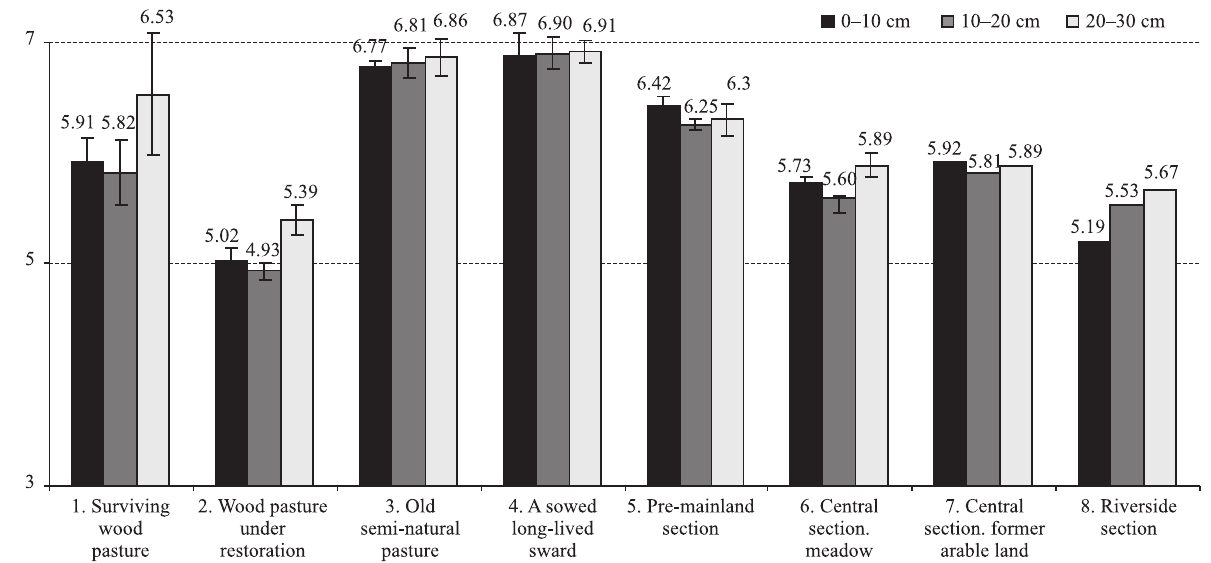
Fig. 1. The pH values in different layers of soil (0–10, 10–20 and 20–30 cm), 2012 Note: vertical bars indicate standard error of means, n =